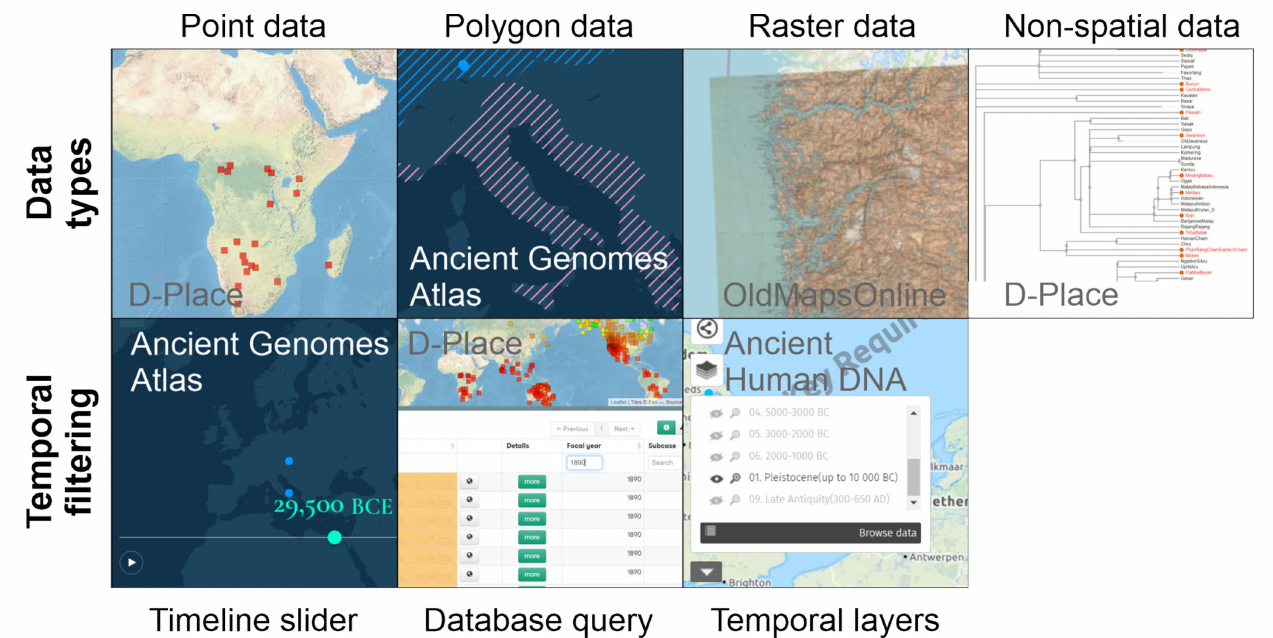
Figure 1. Visualizationof key data types and the functionalities allowing data to be filtered based on time in the reviewed spatial data platforms (see Tables 3 and